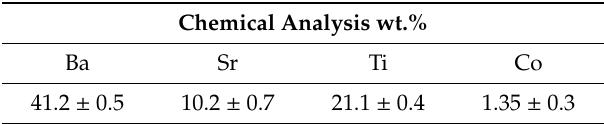
Table 1. The results of elemental analysis determined by